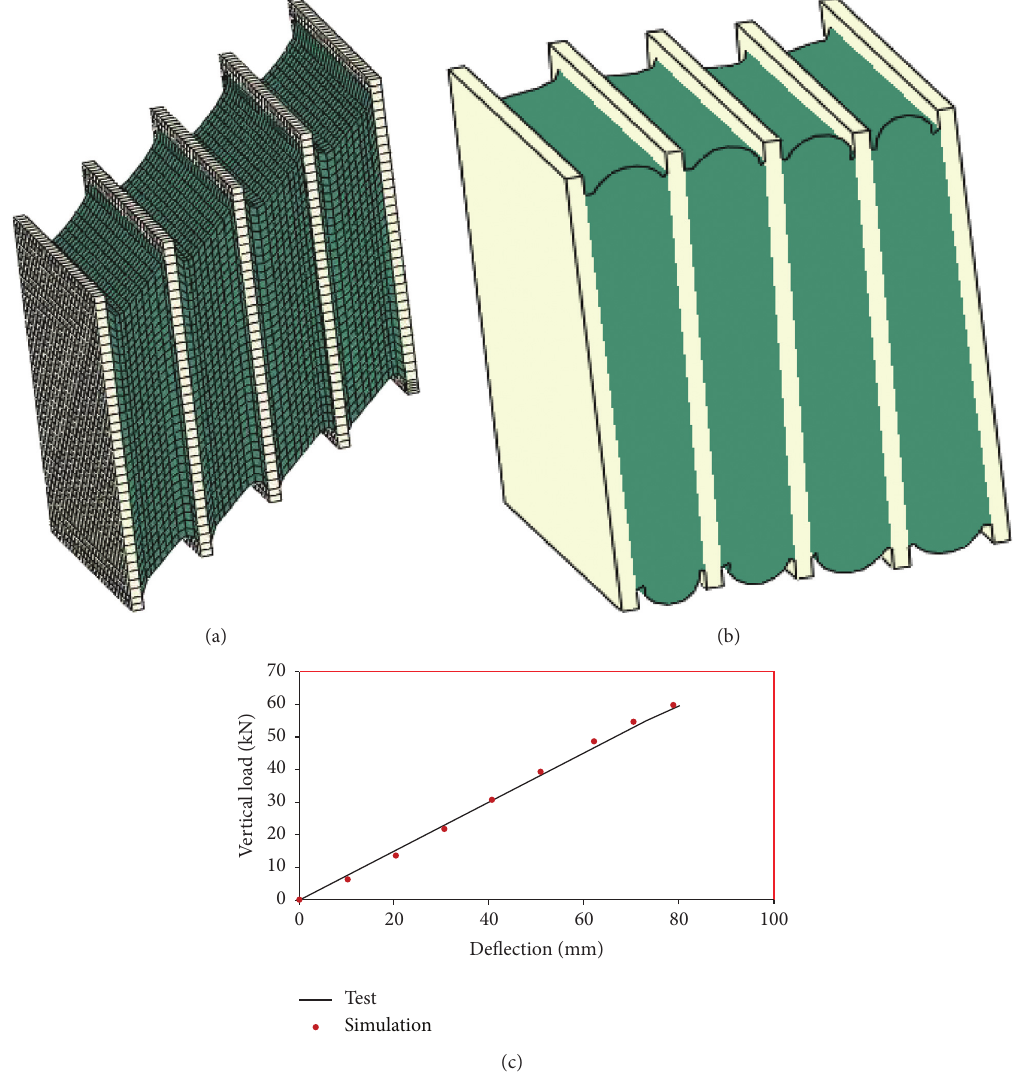
Figure 8: The finite-element model and deformed profile of the sandwich mount with the load-deflection curve comparison. (a) The finite element model of the sandwich mount (green for rubber and white for metal). (b) The deformed profile of the sandwich mount at the vertical load 60kN. (c) The comparison of the load-deflection curves between the simulation and the experiment for the sandwich